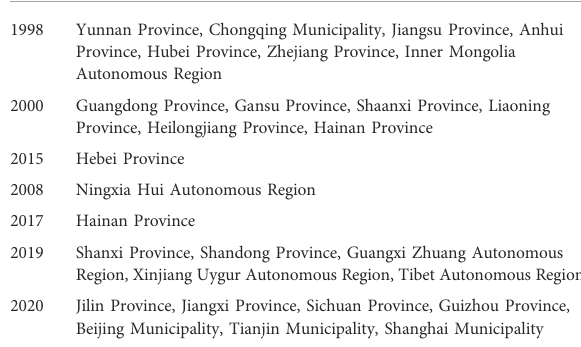
TABLE 2 Implementation of social insurance premium collection and management reform in Chinese provinces and